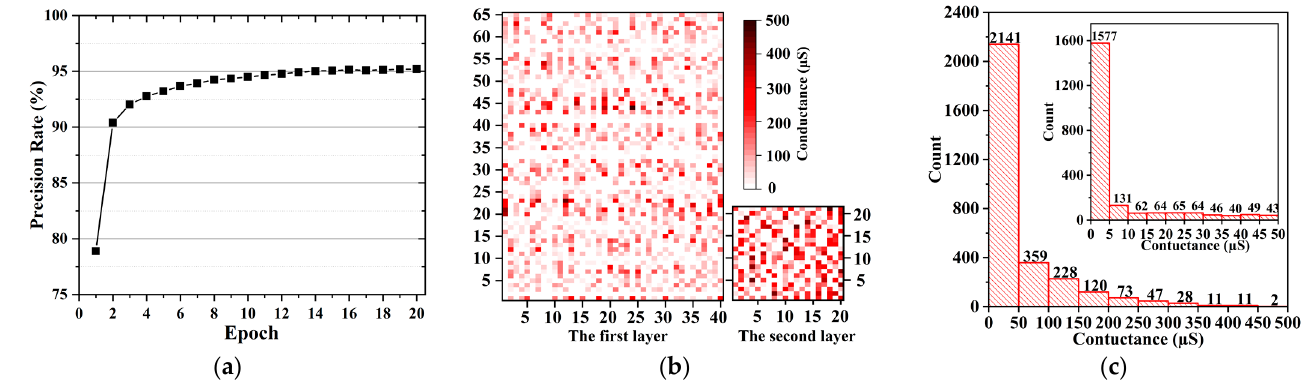
Figure 6. ( a ) The image recognition accuracy rate of the double-layer network varies with the number of cyclic trainings. ( b ) The conductance distribution of the memristor of the double-layer network after training. ( c ) The distribution of the cumulative number of memristor of the double-layer network after training.